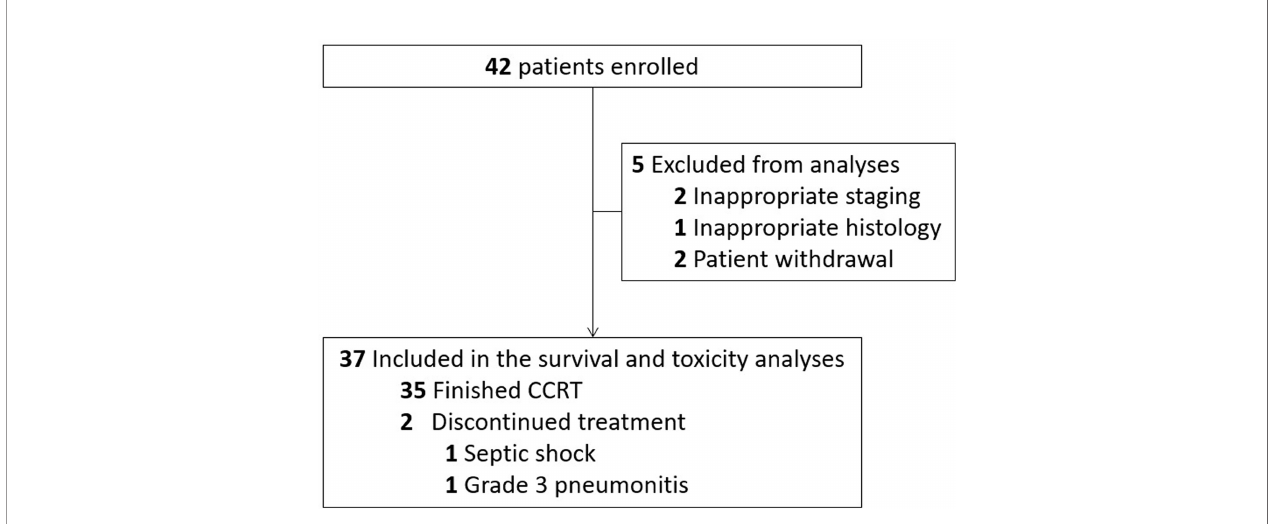
FIGURE 1 | Trial pro fi le. CCRT, Concurrent